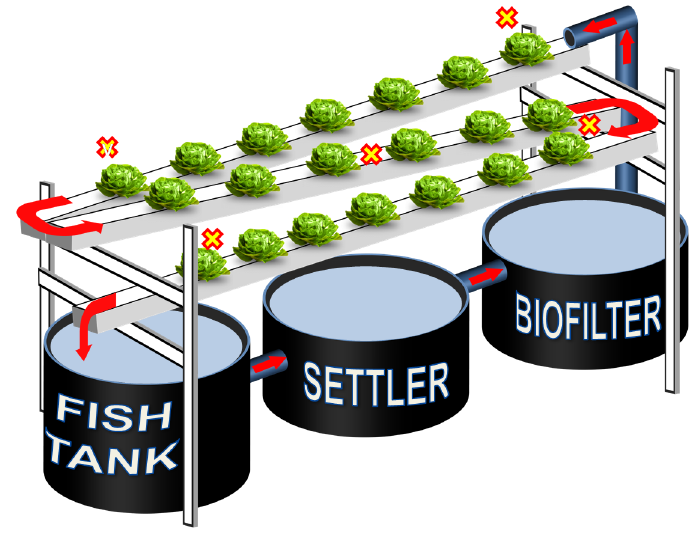
Figure 3. Experimental unit layout. X indicates the sampling points of plants at the harvest time.